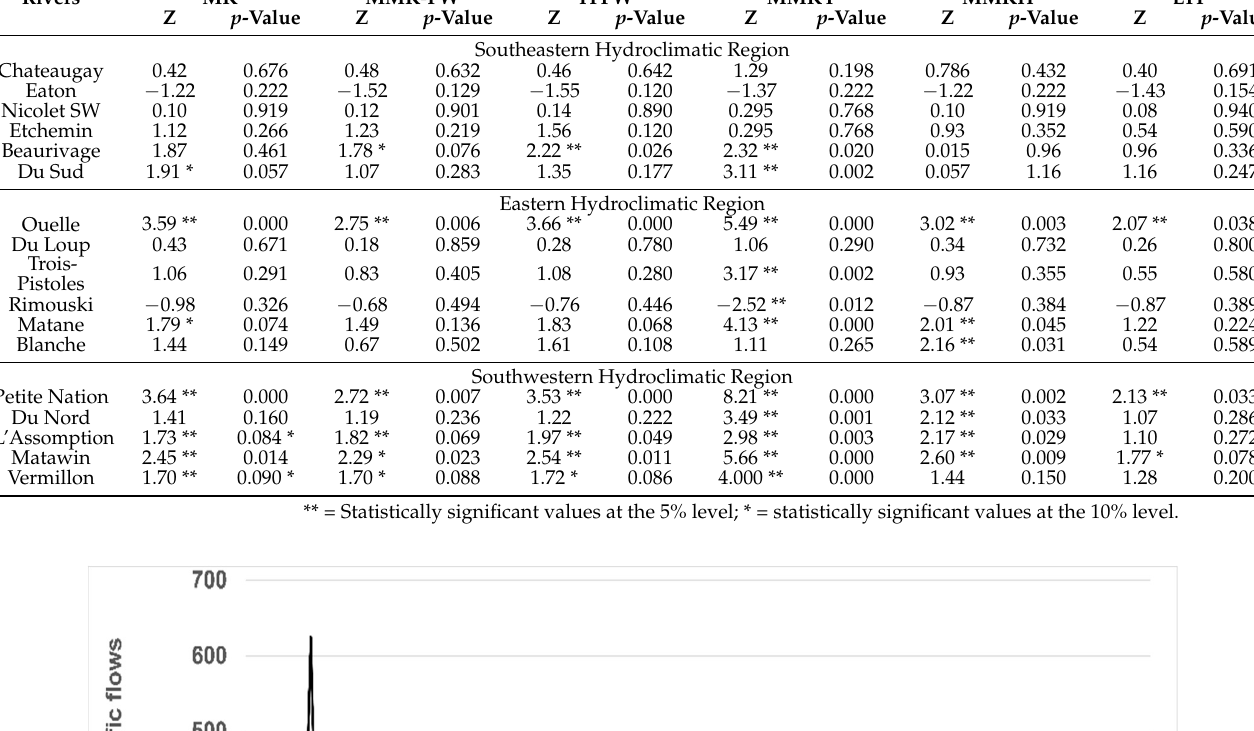
Table 4. Results of the various Mann–Kendall tests applied to daily maximum flow series in spring from 1930–2019.